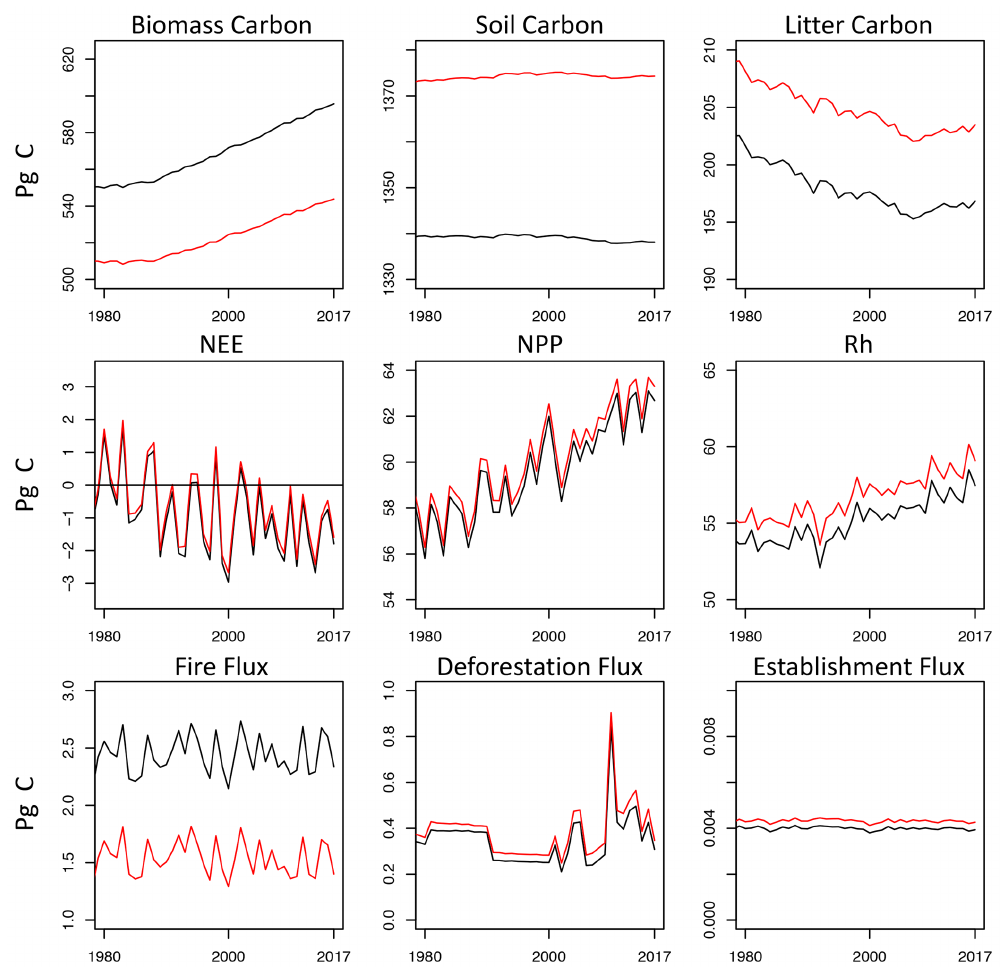
Figure 6. Time series of global carbon stocks and fluxes from LPJ-wsl v2.0 simulation without age classes (black lines) compared against simulations with age classes